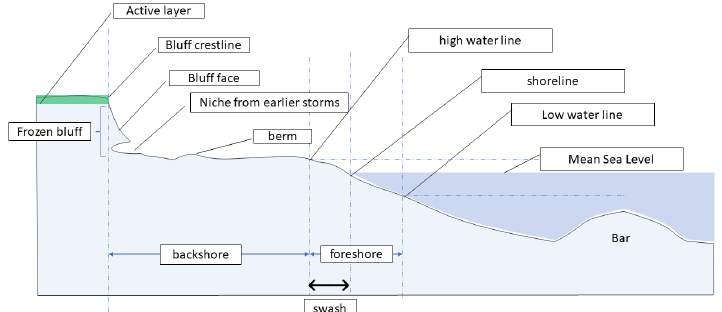
Figure 4. Schematic of a typical Arctic coast. A frozen bluff stands at the end of the beach. Storm surges can flood the beach and reach the base of the bluffs where a niche